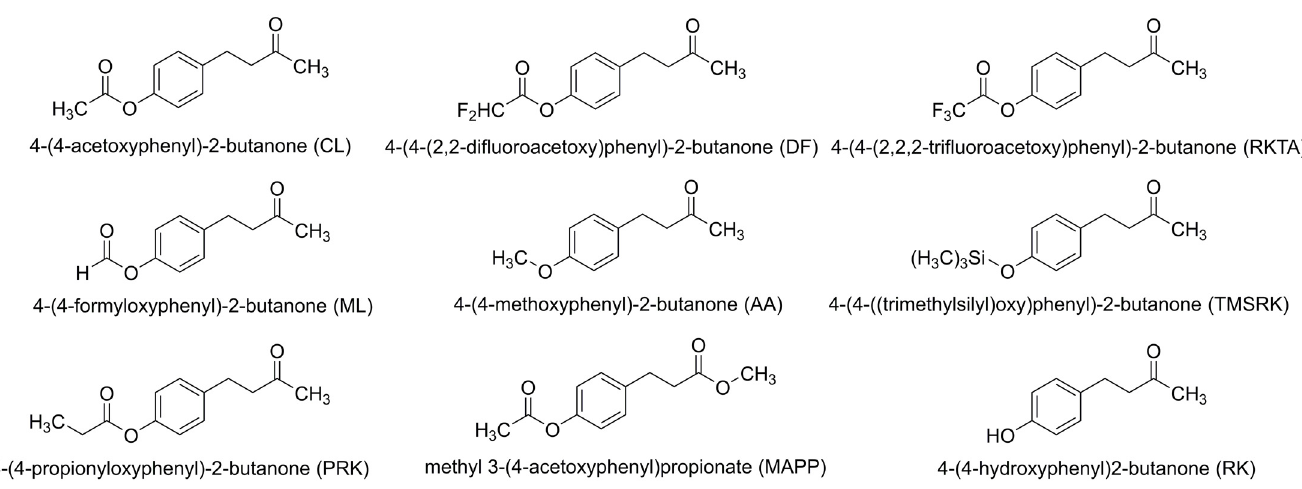
Fig 1. Chemical Structures of the